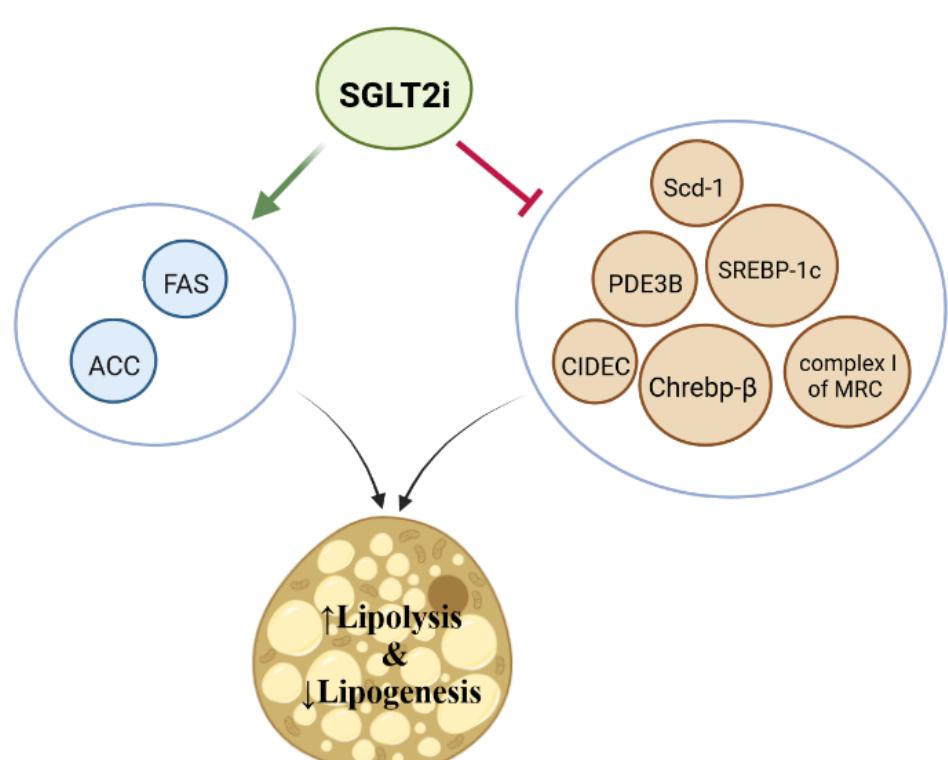
Figure 4. Possible mechanisms involved in SGLT2i dependent lipid biogenesis. SGLT2 inhibition reduces lipogenesis and induces lipolysis upregulating ACC (acetyl-CoA carboxylase) and FAS (fatty acid synthase) and downregulating Scd-1 (Stearoyl-CoA desaturase-1), PDE38 (Phosphodiesterase 3B), SREBP-1c (sterol response element-binding protein 1c), CIDEC (Cell death inducing-DFFA like effector C), Chrebp-β (Carbohydrate response element-binding protein-beta), and the activity of complex 1 of